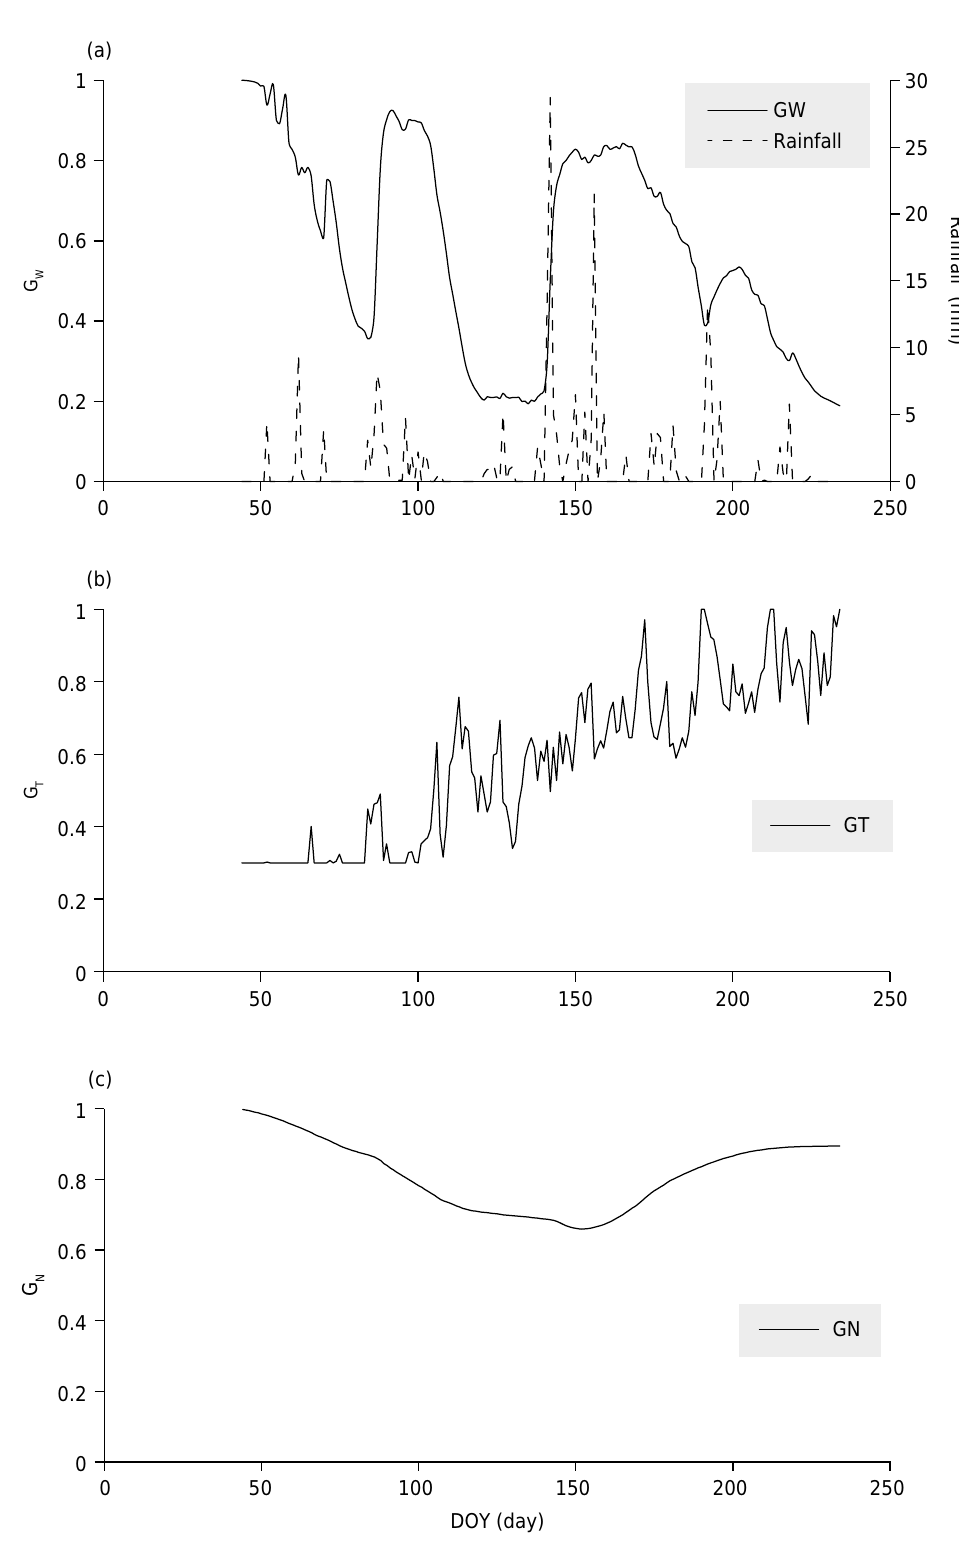
Figure 8. Variety of growing coefficient G W , G T and G N with